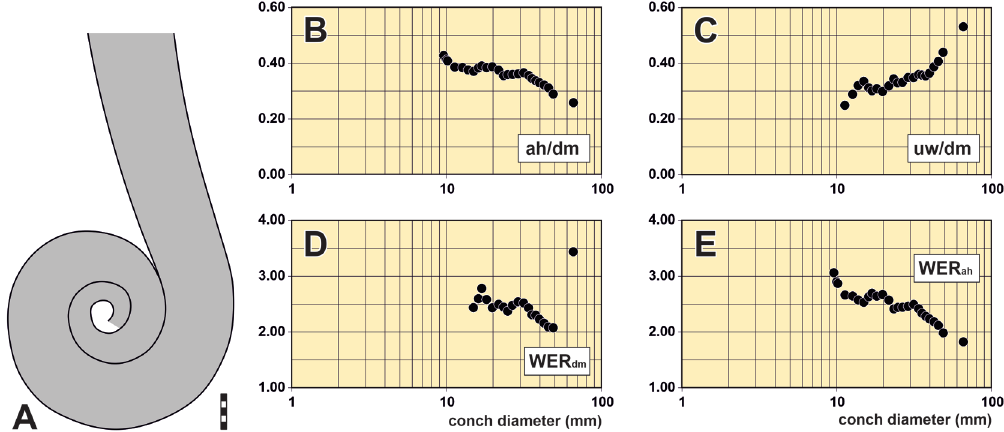
Fig. 71. Trilacinoceras cf. hunanense Lai & Qi, 1977. A . Coiling outline of specimen MB.C.29655. B–E . Conch proportions and coiling rates of specimen MB.C.29655. Scale bar units = 1